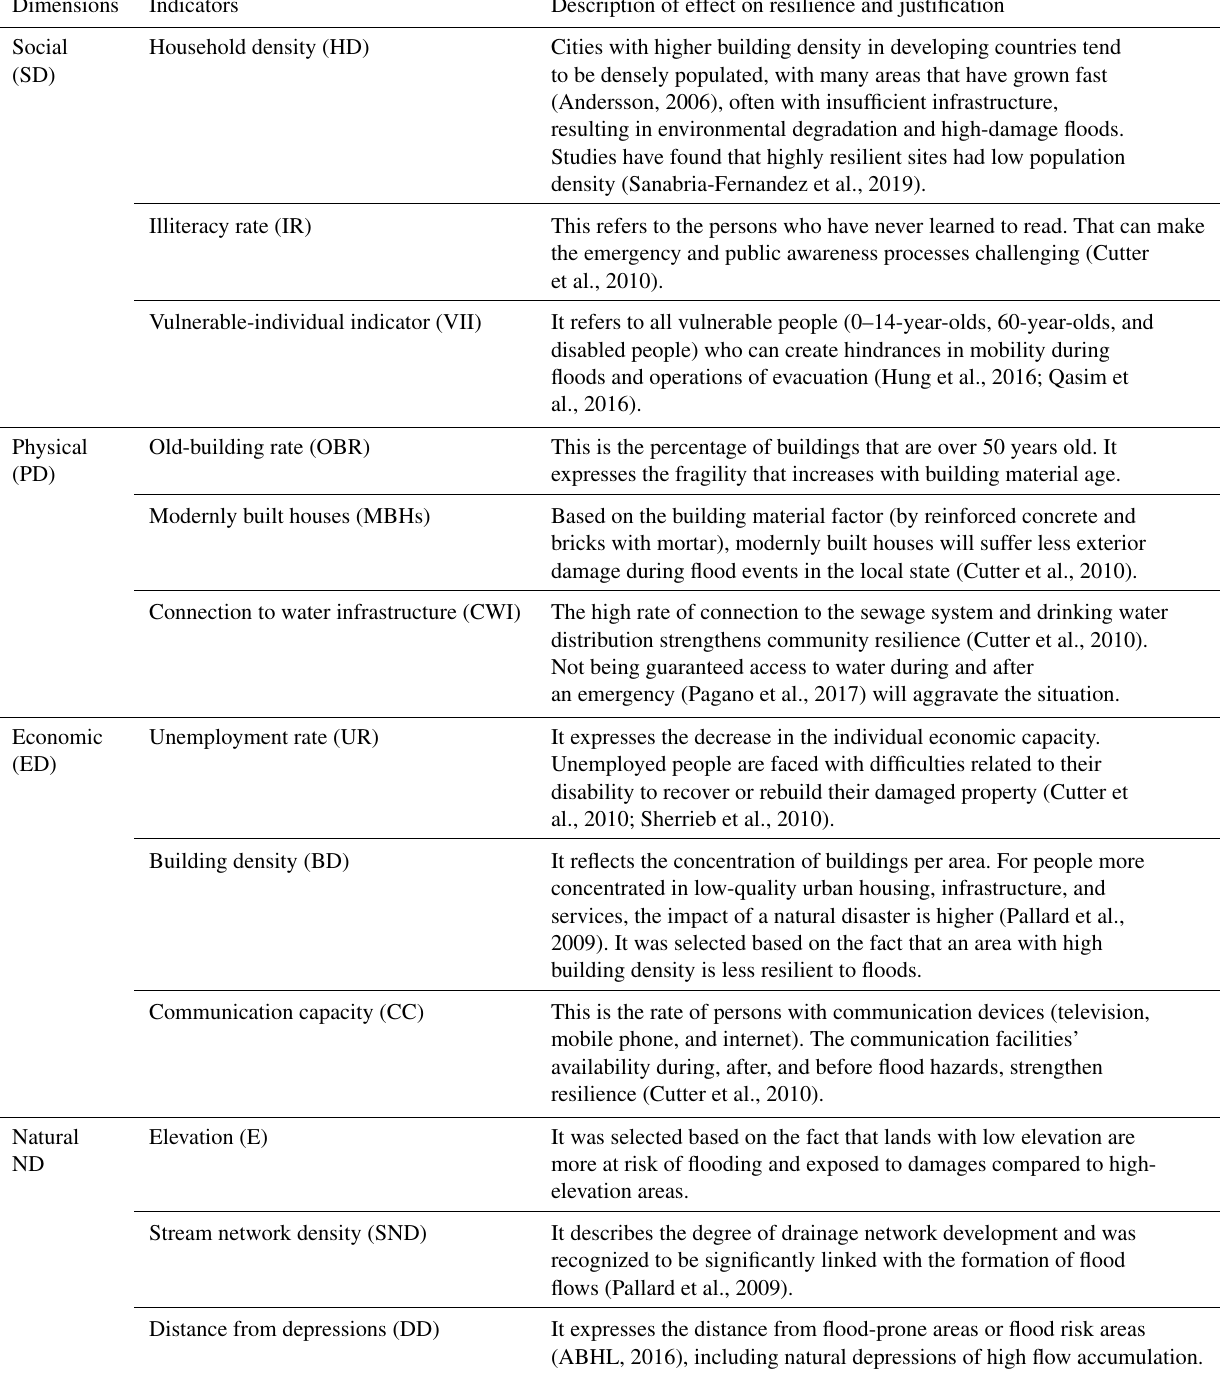
Table 1. Indicator descriptions selected to assess the flood resilience in the Fnideq, M’diq, and Martil areas (compiled from different sources).